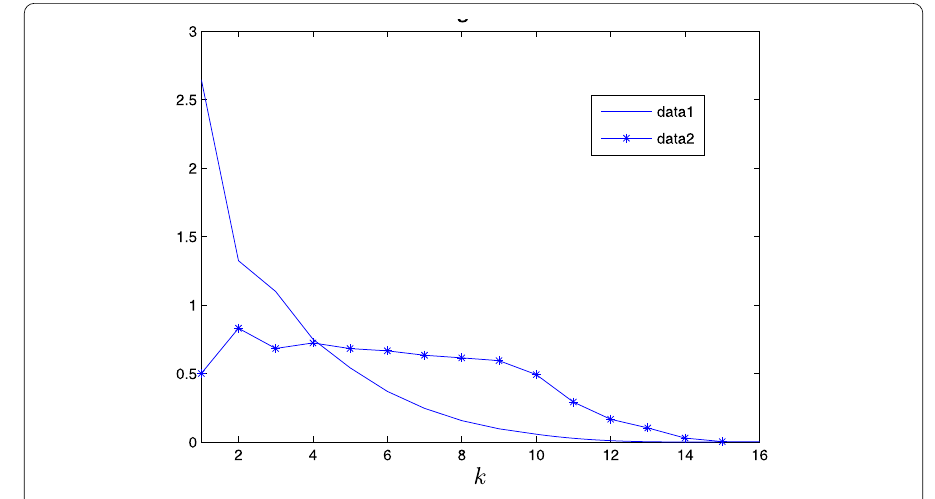
Figure 1 The convergence rate of Algorithm 1